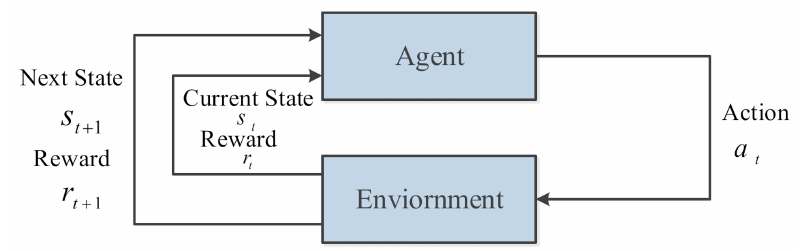
Figure 2. Markov decision